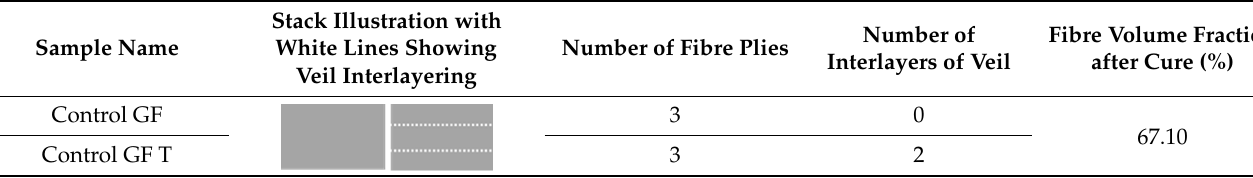
Figure 1. Differential scanning calorimetry, showing a peak at 155 °C consistent with manufacturing information. Table 2. Stacking Sequence for Hybrid Fibre Samples. Table 2. Stacking Sequence for Hybrid Fibre